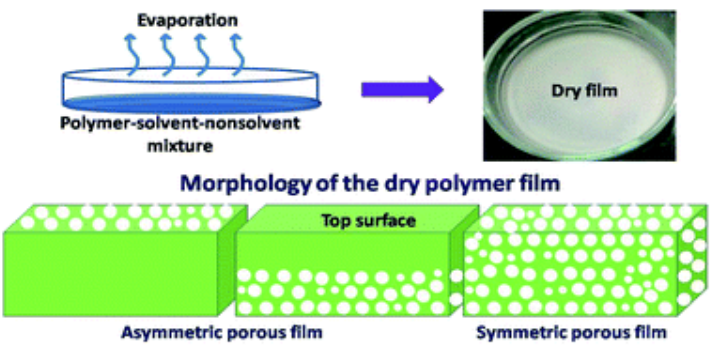
Figure 5. Solvent evaporation induced phase separation (EIPS). Reprinted from [27], Copyright 2019 Royal Society of Chemistry.